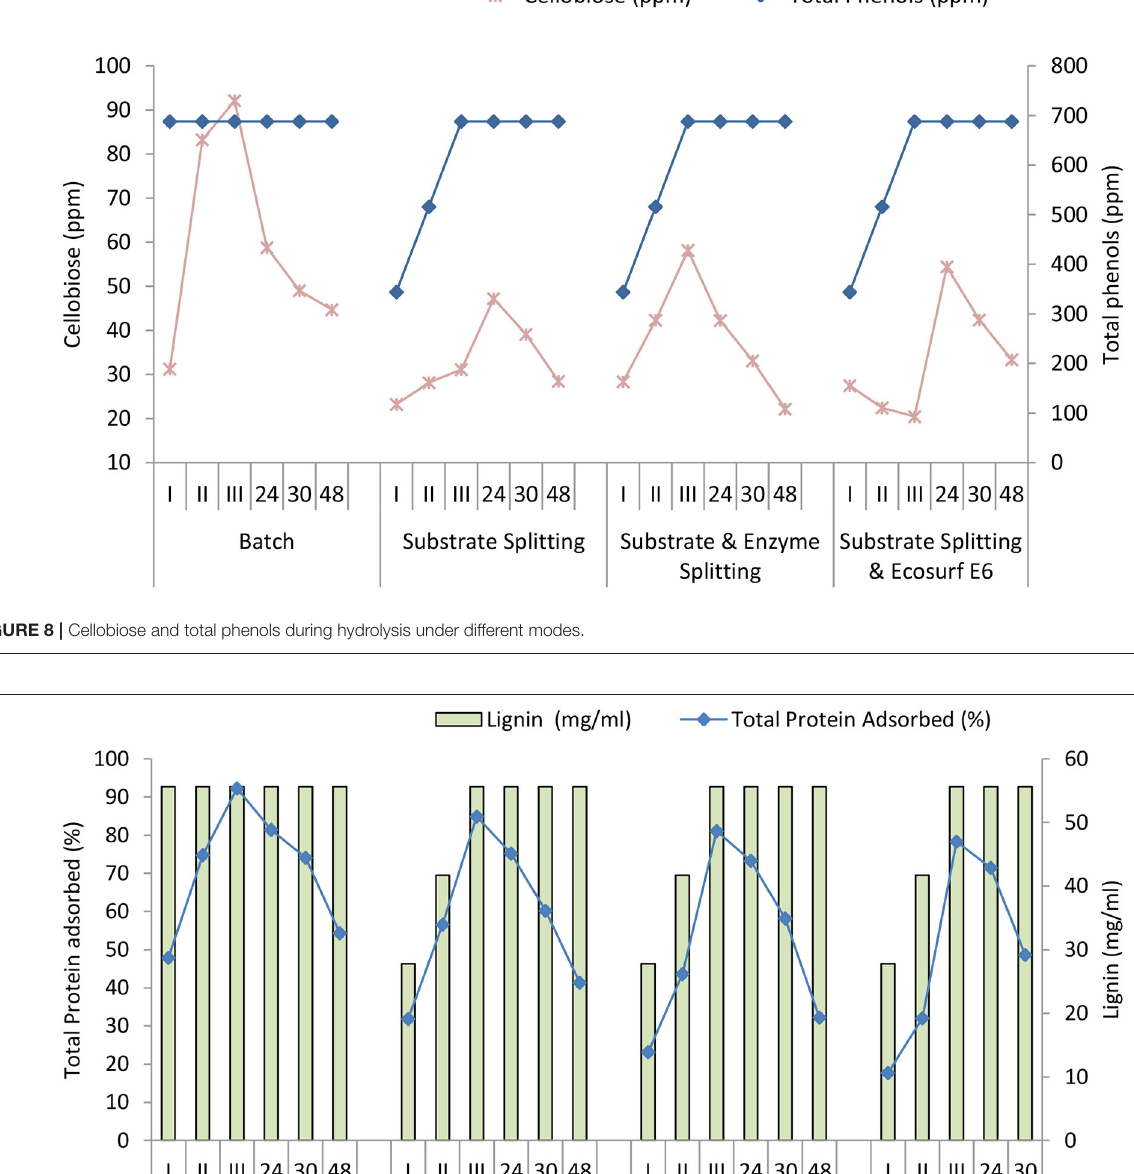
varies among the batch and fed-batch modes of hydrolysis, the latter causing reduced adsorption of the enzyme or the protein, which may cause better hydrolysis in the fed-batch mode. The lower lignin content in the initial hours of hydrolysis in the three fed-batch modes could be directly related to the